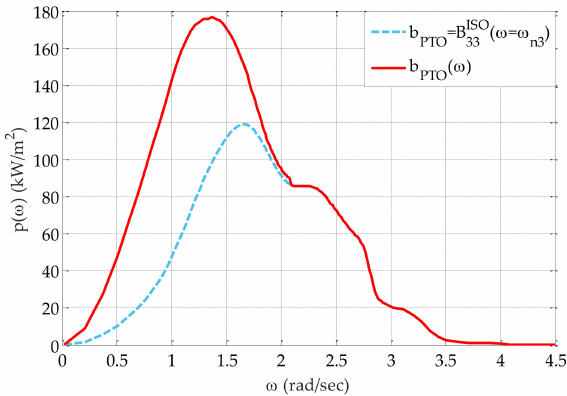
Figure 17. Comparisonof the mean power absorbed by the array with oblate spheroidal WECs and d net = 0.125 r 0 under the action of regular waves with β = 45 o by utilizing ( a ) a PTO with constant (cid:1) (cid:0) b PTO equal to B ISO ω = ω ISO ; ( b ) an “active” PTO with b PTO ( ω ) n 3 33